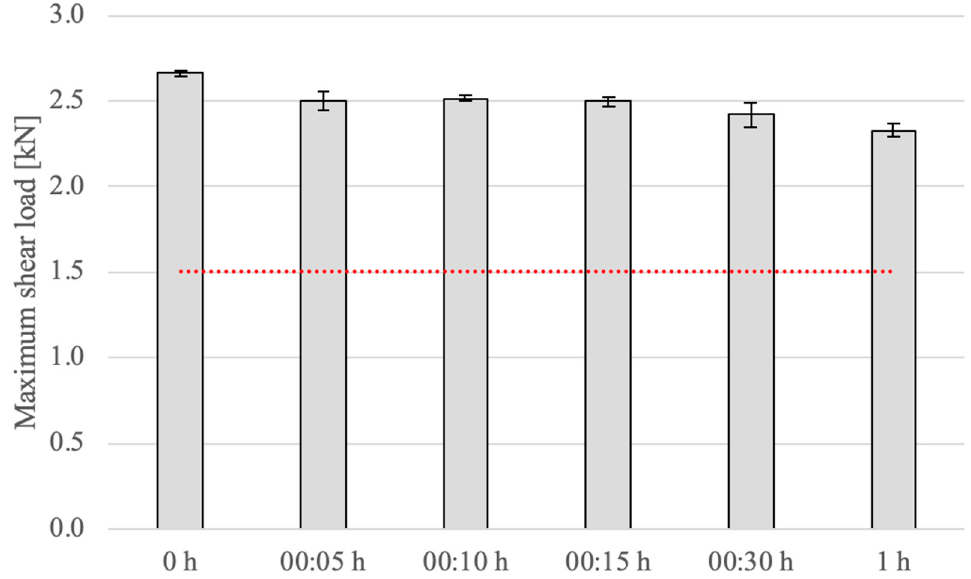
Figure 16. Maximum shear strength of RJS specimens continuously immersed in an ultrasound mixture. The red dotted line represents the threshold value for the RJS specimen’s minimum allowed joint strength (1.5 kN).